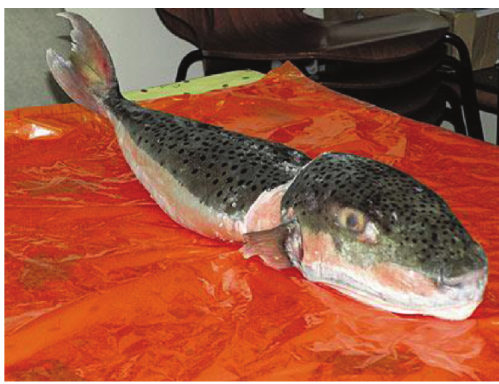
Figure 1: Lagocephalus sceleratus (Pu ff erfish, fugu) cought by a local recreational fisherman o ff the cost of Tel